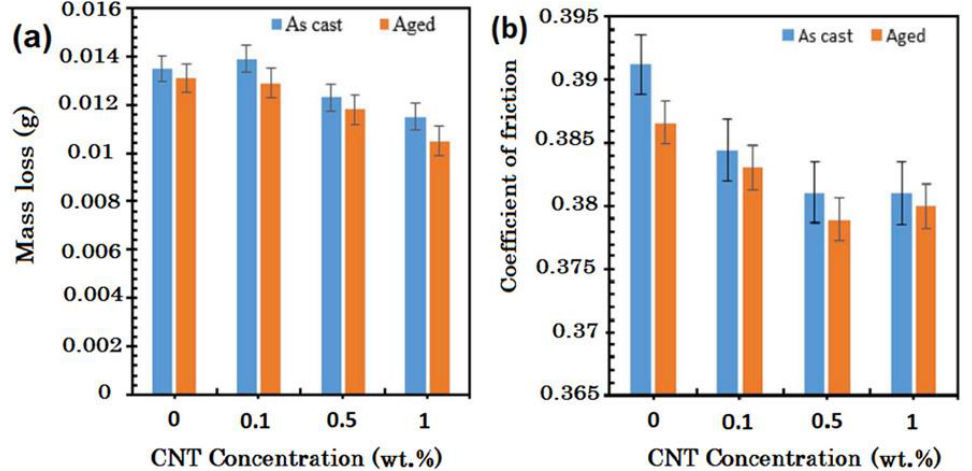
Figure 7. Plots pertaining to the variation in ( a ) mass loss due to wear, and ( b ) coefficient of friction in contradiction to CNTs ’ concentration in AZ31-based CNT-reinforced composites in dry friction situations [36].